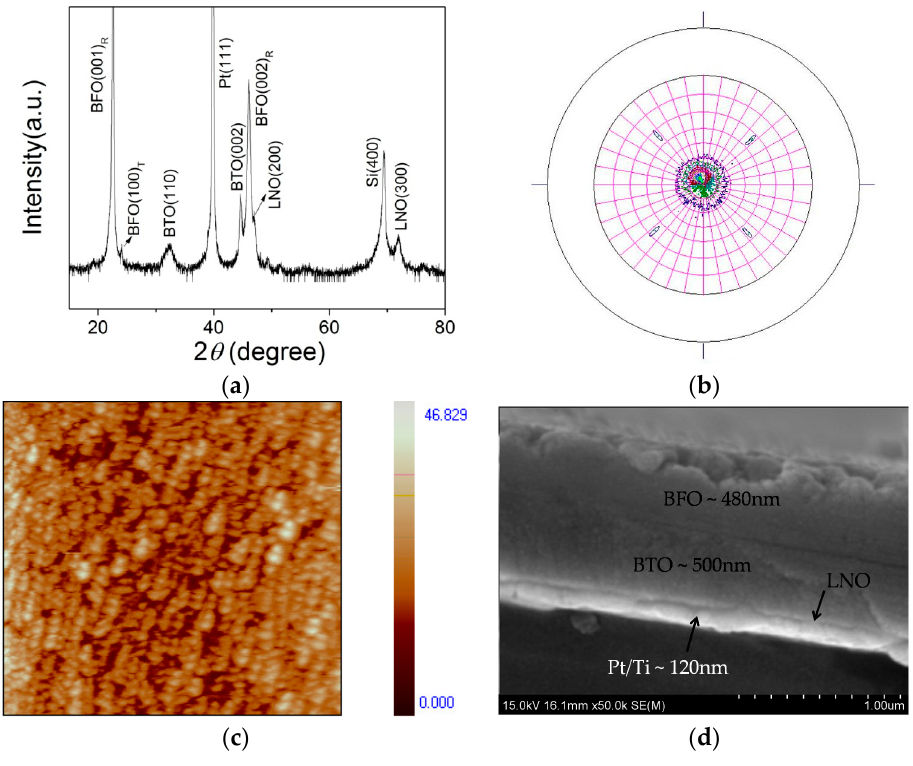
Figure 3. ( a ) XRD 2 θ scan spectrum (R-rhombohedral, T- tetragonal for BFO peaks, while the BTO phase is tetragonal); ( b ) X-ray pole figure analyses by using the (001) R BFO peak; ( c ) AFM surface scan image (5 µ m × 5 µ m); and ( d ) cross-sectional SEM image of the BiFeO 3 /BaTiO 3 bi-layer film deposited on LaNiO 3 /Pt/Ti/SiO 2 /(100) Si